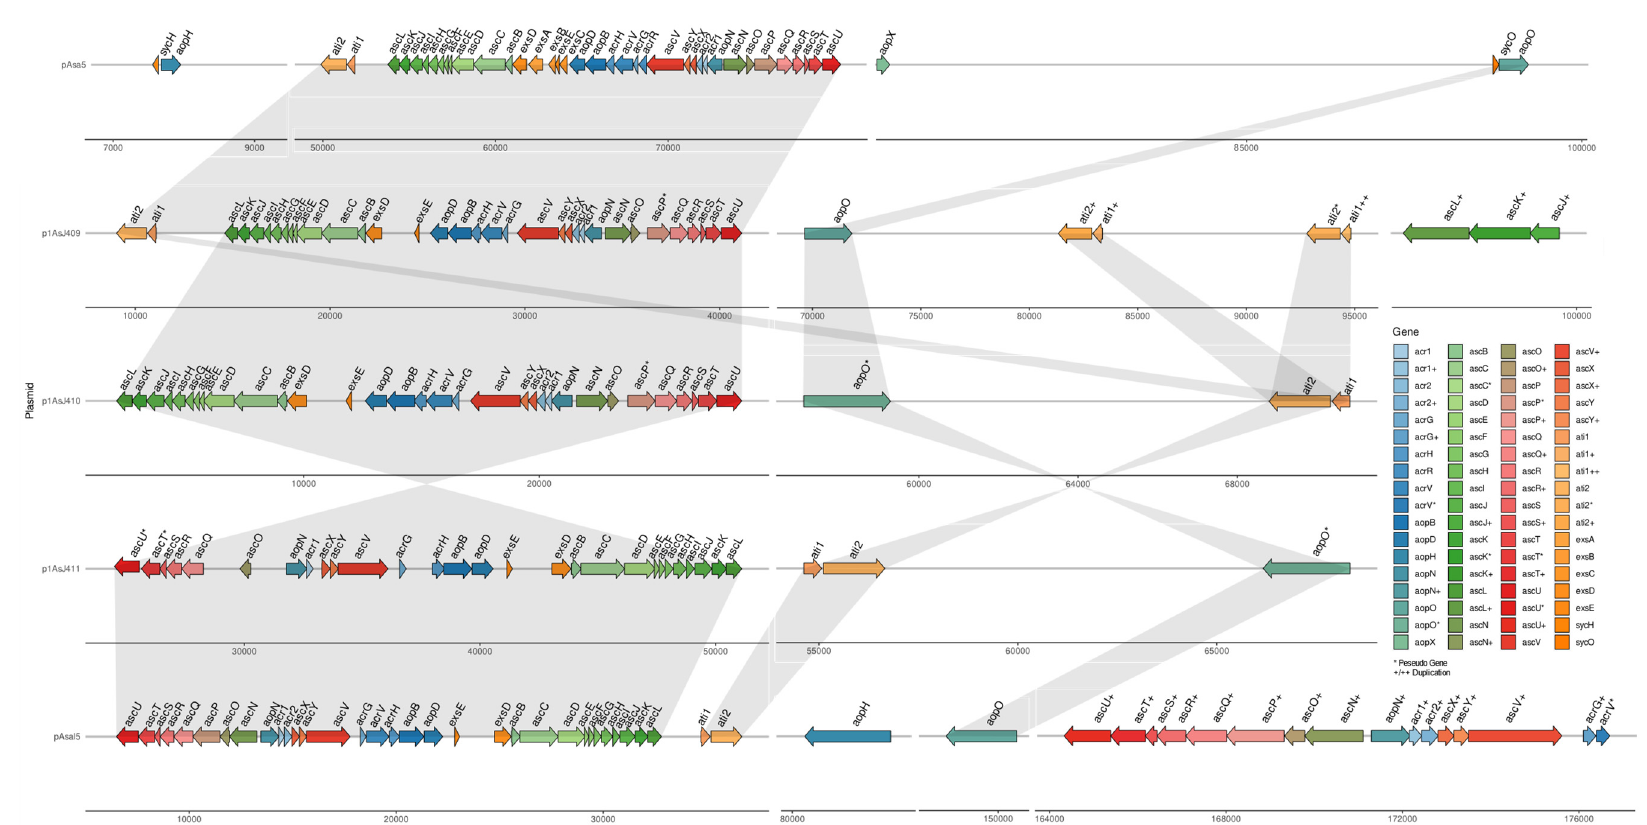
Figure 7. Typical and atypical type III secretion system gene structure comparison. Atypical A. salmonicida virulent plasmids p1AsJ409, p1AsJ410, and pAs1J411 were compared with each other and with the typical A. salmonicida virulent plasmids pAsa5 (A449 strain, top) and pASal5 (J223 strain, bottom). Three main operons were identified among plasmid sequences. Genes are illustrated by arrows. Similar regions were identified between the plasmids, but differences in their position were observed. Pseudogenes are indicated by an asterisk (*), and gene copies are indicated by a plus symbol (+ for a single copy/++ for two copies).